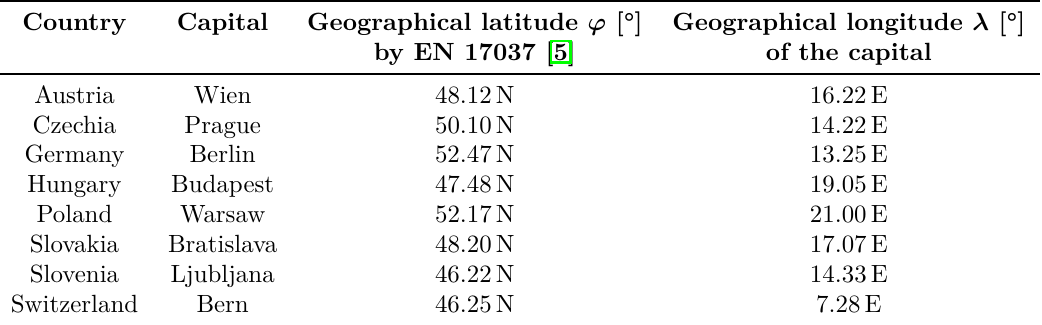
Table 1. Considered localities and their